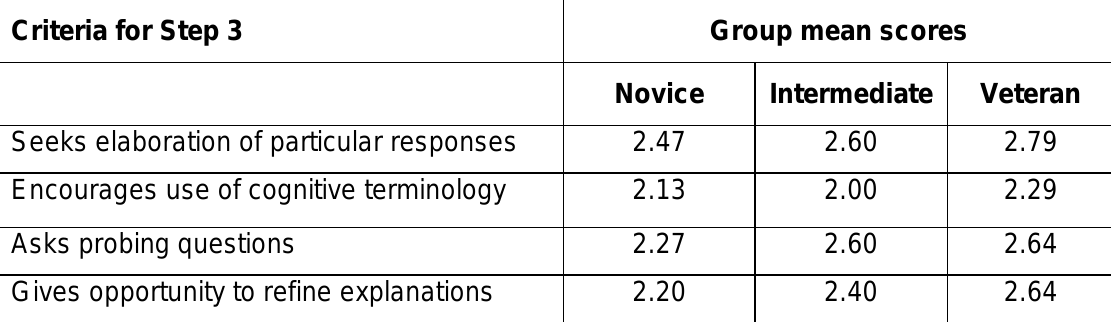
Comparison of facilitator mean scores, across facilitator categories, on their ability to encourage participants to explain the concept and define the terms.